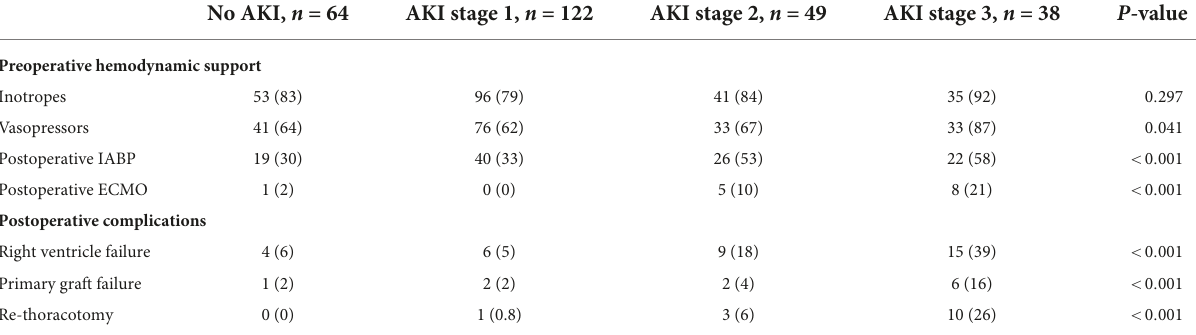
TABLE 2 Echocardiographic characteristics according to the postoperative AKI stage.